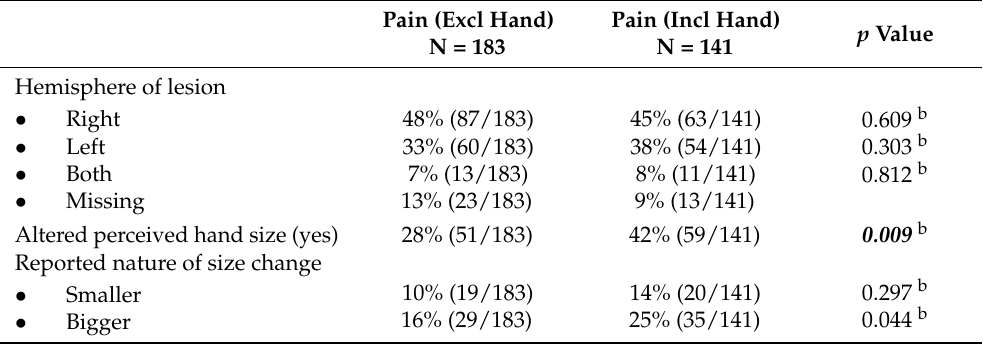
Table 2. Comparison of hemisphere of lesion and hand size for individuals with chronic pain including and excluding the hand.